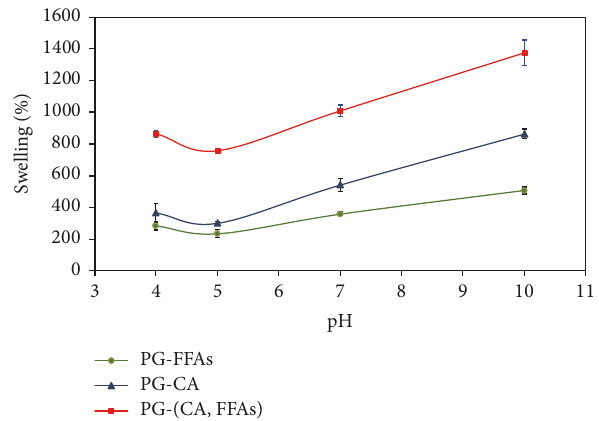
Figure 7: pH-dependent swelling behavior of treatments PG-FFAs ( e ),PG-CA( 󳵳 ),andPG-(CA,FFAs)( ◼ ),measuredat25 ∘ C.Swelling percentage was calculated using (1).